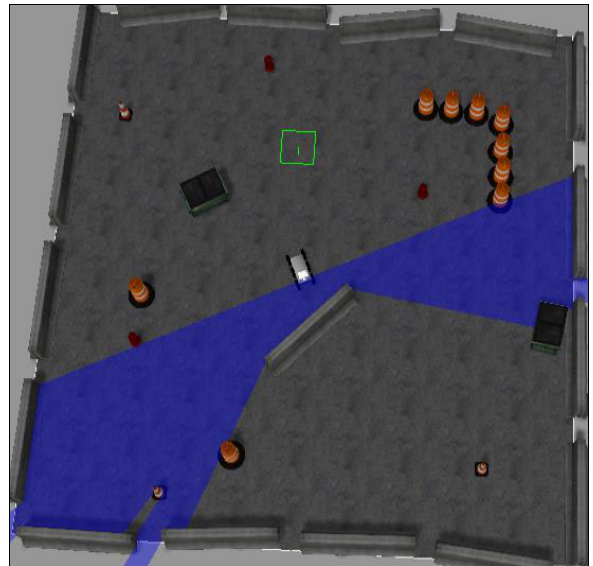
Figure 7. Mapping by MOOR in simulation